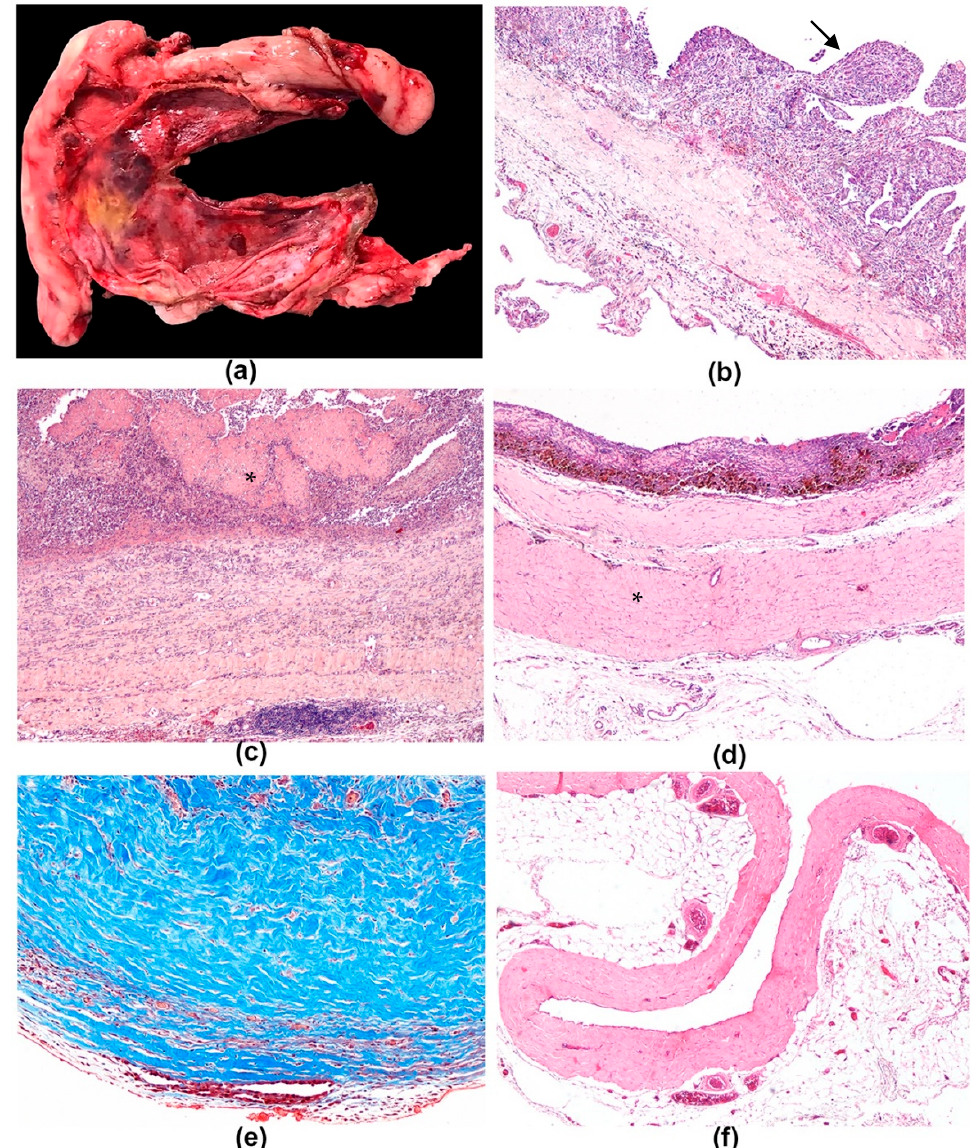
Figure 1. Idiopathic pericarditis, dog. ( a ) Pericardial sac of dog that underwent subtotal pericardiectomy, diagnosed with chronic idiopathic pericarditis. Serosa is variably thickened by multifocal- coalescing whitish areas of fibrosis; multifocal areas of hemorrhages and a focal area of gray-yellowish fibrin exudation at the inner/cardiac side of the serosa are present, 40×. ( b – d ) Idiopathic pericarditis, dog, H&E. ( b ) Mesothelial papillary hyperplasia, simple to branching papillae (arrow) lined by cuboidal mesothelial cells supported by a small axis of fibrovascular stroma infiltrated with inflammatory cells, 100×. ( c ) Fibrinous pericarditis, pericardium is covered by a thick mat of fibrin (asterisk) and expanded by abundant fibrosis in which multifocal aggregates of inflammatory cells are embed- ded, 100 × . ( d ) Fibrous pericarditis, pericardium is replaced by abundant fibrosis (asterisk), 100 × . ( e ) Idiopathic pericarditis, dog, Masson’s trichrome. Mature collagen is stained in blue, 100 × . ( f ) Control pericardial tissue appeared as normal pericardium with the inner, cardiac surface covered by a single layer of flat mesothelial cells; the parietal pericardium was composed of poorly vascularized fibrous tissue and overlies mediastinal adipose tissue, 40 ×